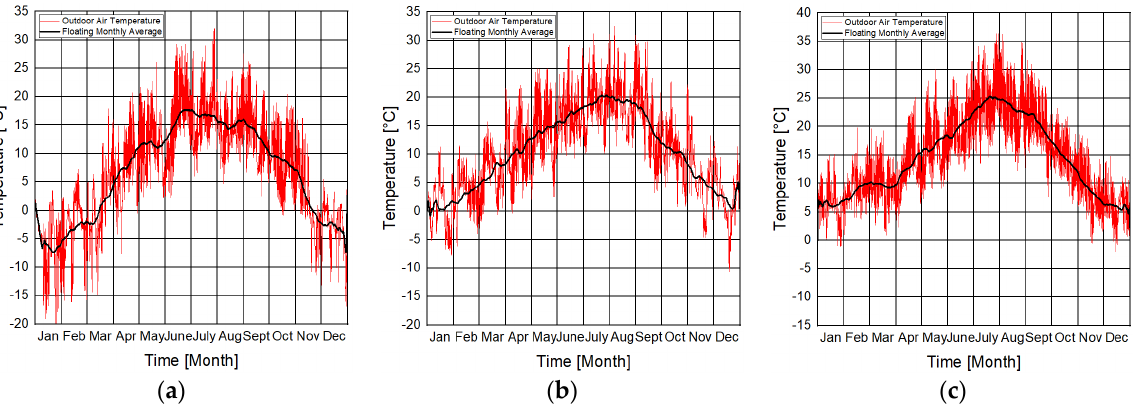
Figure 2. Outdoor air temperatures for ( a ) Holzkirchen (DE), ( b ) Freiburg (DE) and ( c ) Madrid (ES) as hourly mean values (red curve) and floating monthly average (black curve) [48].